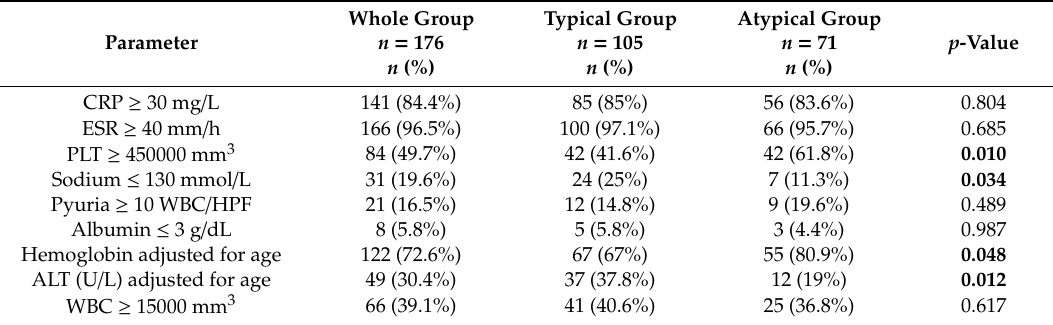
Table 4. Laboratory findings at diagnosis in typical and atypical KD